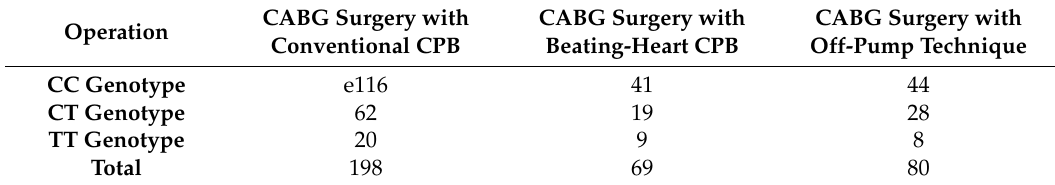
Table 1. Patients (total 347) with CC, CT, or TT